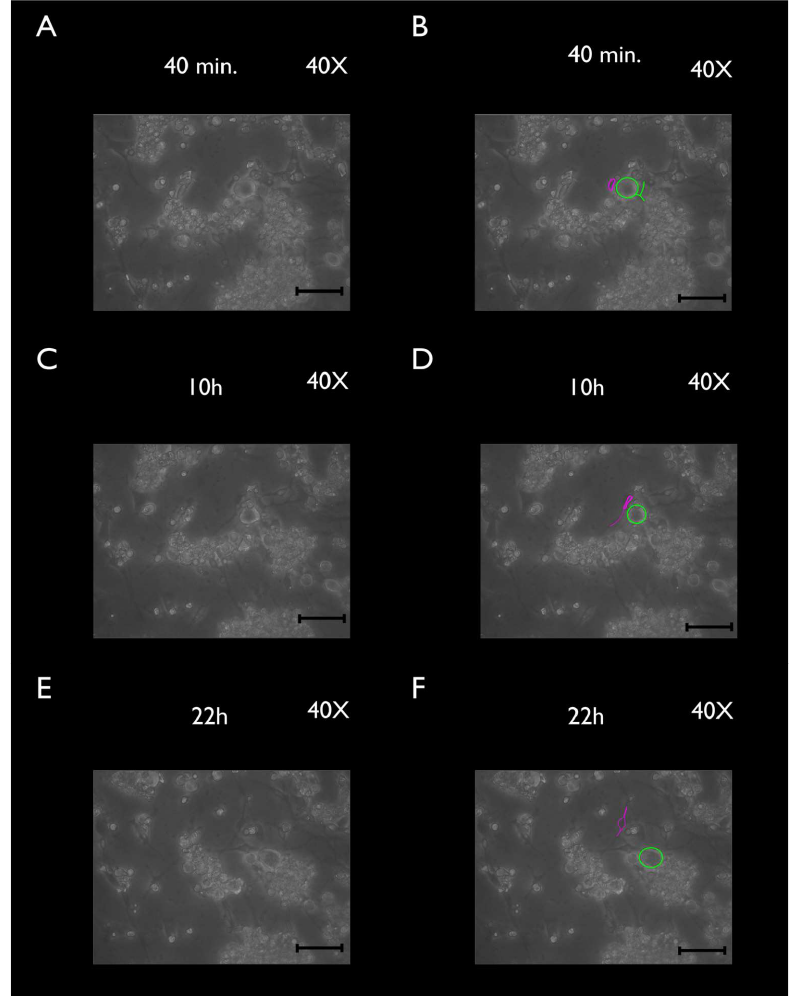
Figure 6. Time-lapse frames of cultured TGCs during the first 22 h (40× magnification). Pseudouni-